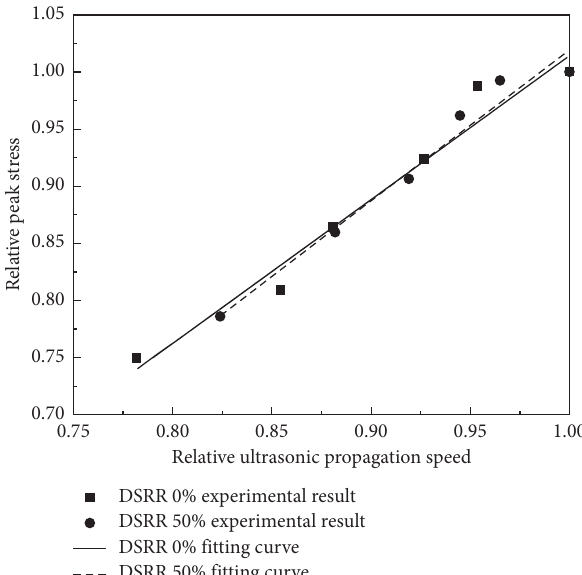
Figure 15: Relation between relative peak stress and relative ul- trasonic propagation speed.